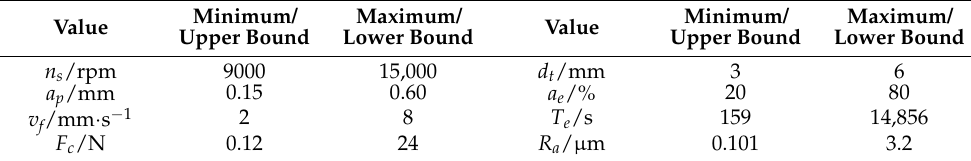
Table 4. Design constraints and boundary conditions.